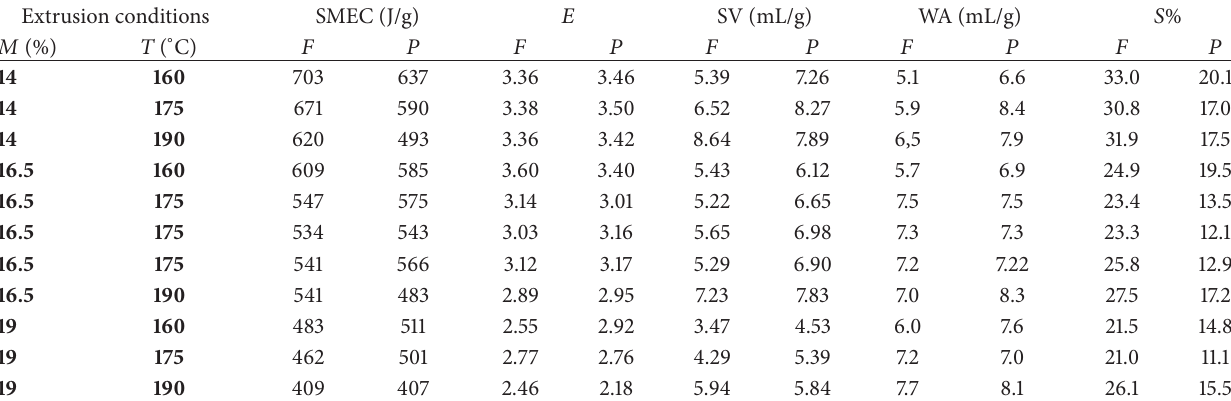
Table 2: Specific mechanical energy consumption (SMEC), expansion ( 𝐸 ), specific volume (SV), water absorption (WA), and solubility ( 𝑆 %) corresponding to the eleven experimental extruded samples and for the two rice